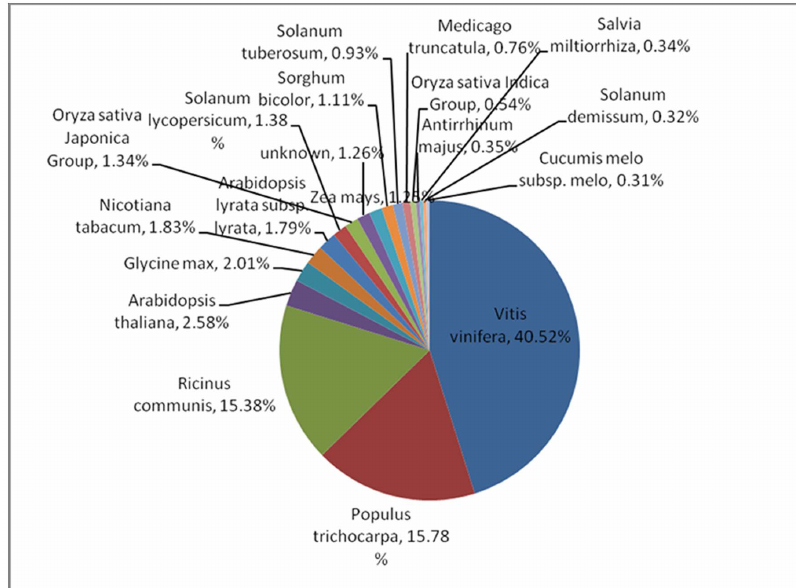
Figure 1. Similarity analysis based on the best hit.